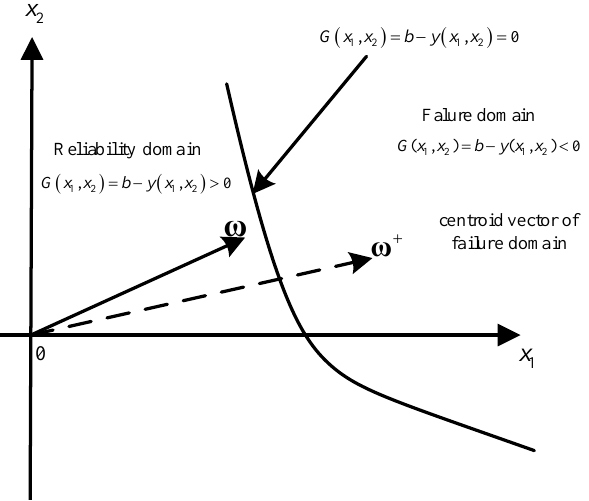
Figure 1. The diagram of the centroid vector of a failure domain in 2-dimensional space. Figure 1 suggests that ω + is paralleled with the gradient direction of state function G ( ω ) . ω + denotes the unit vector of G ( ω ) at the design point along the gradient direction. The distance (cid:107) ω + (cid:107) =